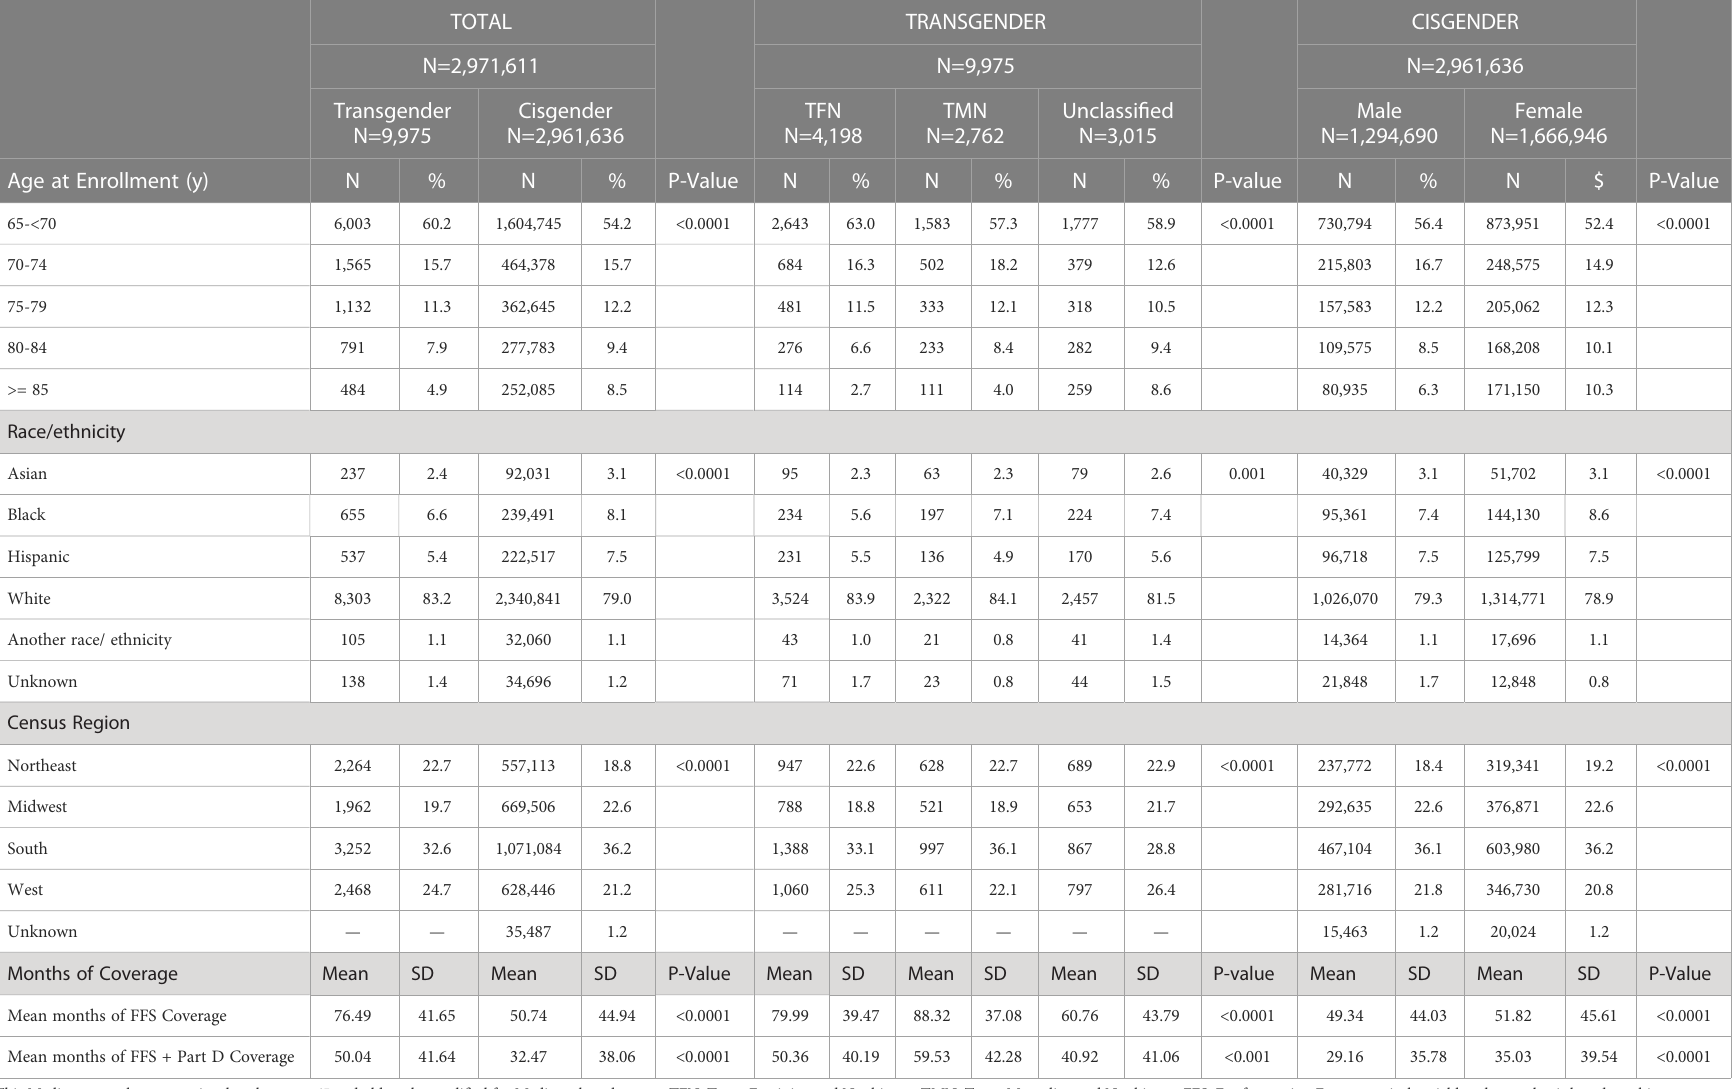
TABLE 1 Demographics at enrollment among age-entitled bene fi ciaries strati fi ed by inferred gender in a national Medicare population,